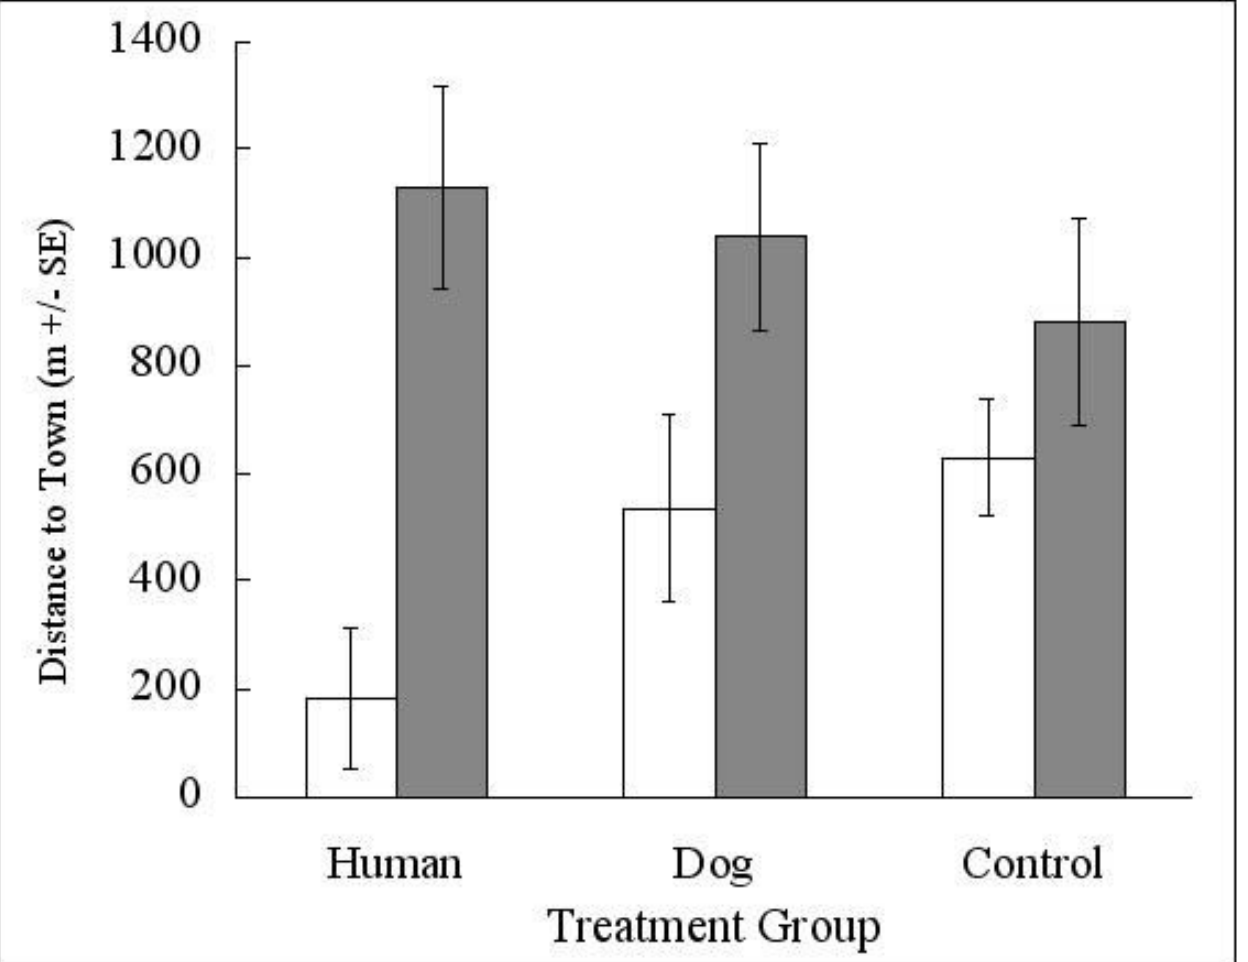
Fig. 5. Average elk daily distance (m ± SE) to the closest point on the town boundary, before (white column) and after (black column) aversive conditioning treatments were applied to the three treatment groups in Banff National